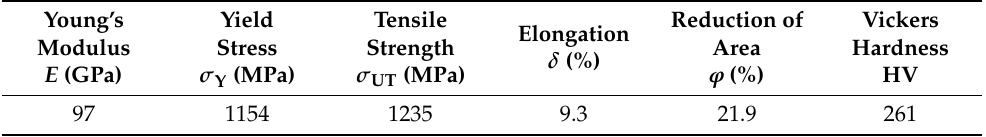
Table 1. Mechanical properties of Ti–22V–4Al